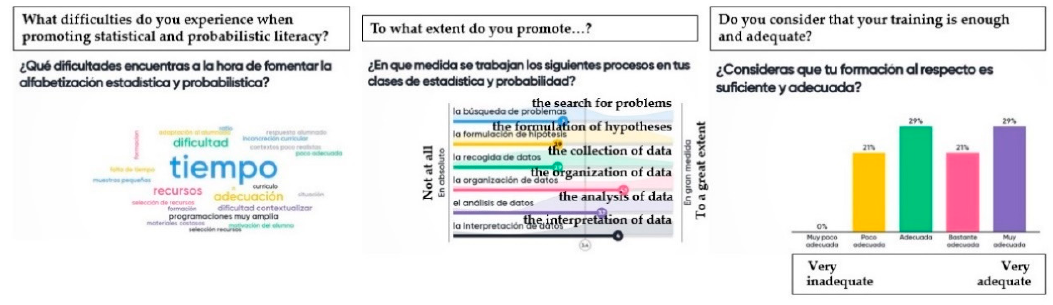
Figure 5. Results of the Mentimeter ® moderation method used during the second and third sessions.